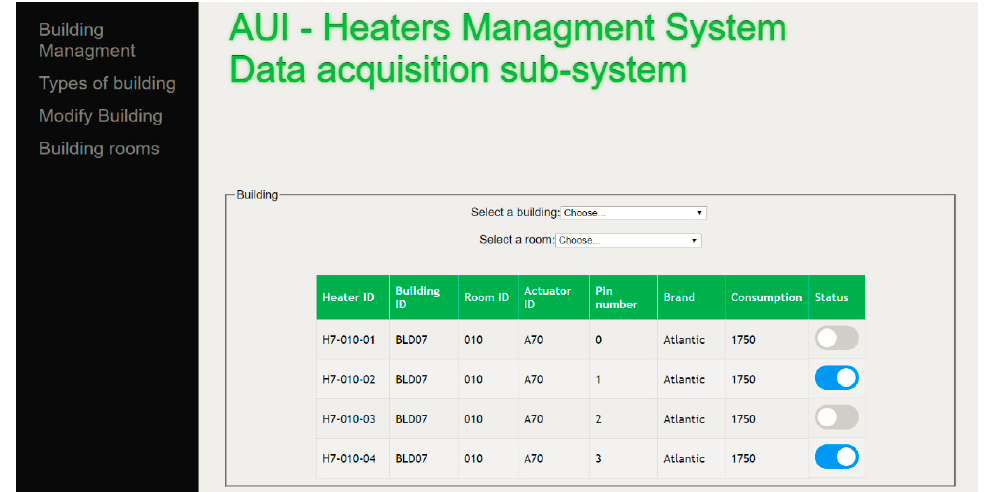
Figure A4. The application getting an update about the status of the heater.